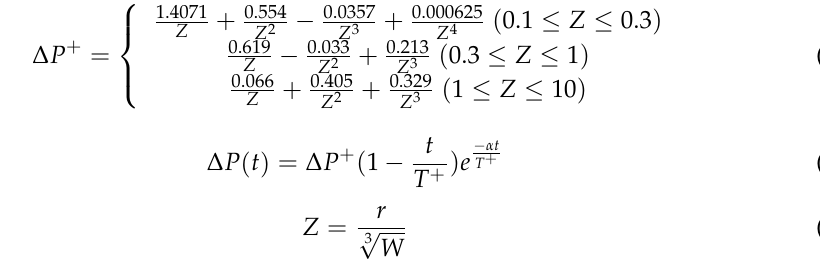
Figure 2. Explosion shock wave overpressure decays with time.